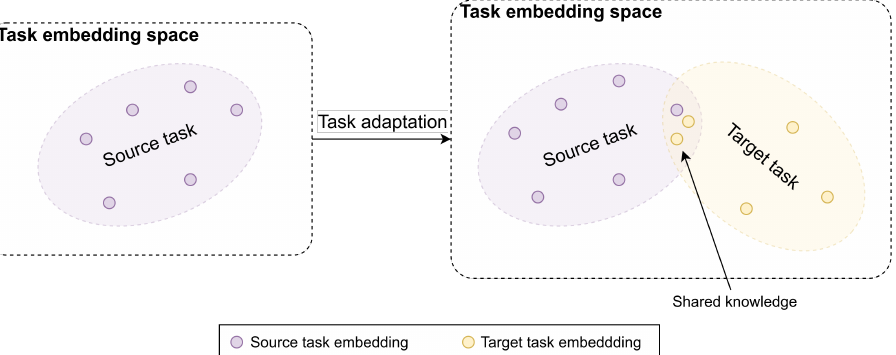
Figure 1. An illustration of the task embedding space. Purple and yellow regions denote the knowledge learned from the source and target tasks, respectively. Applying the proposed task adaptation algorithm will lead to the expansion of the task embedding space due to the acquisition of the knowledge of the target task. In addition, the intersection between those two regions indicates the shared common knowledge between the two